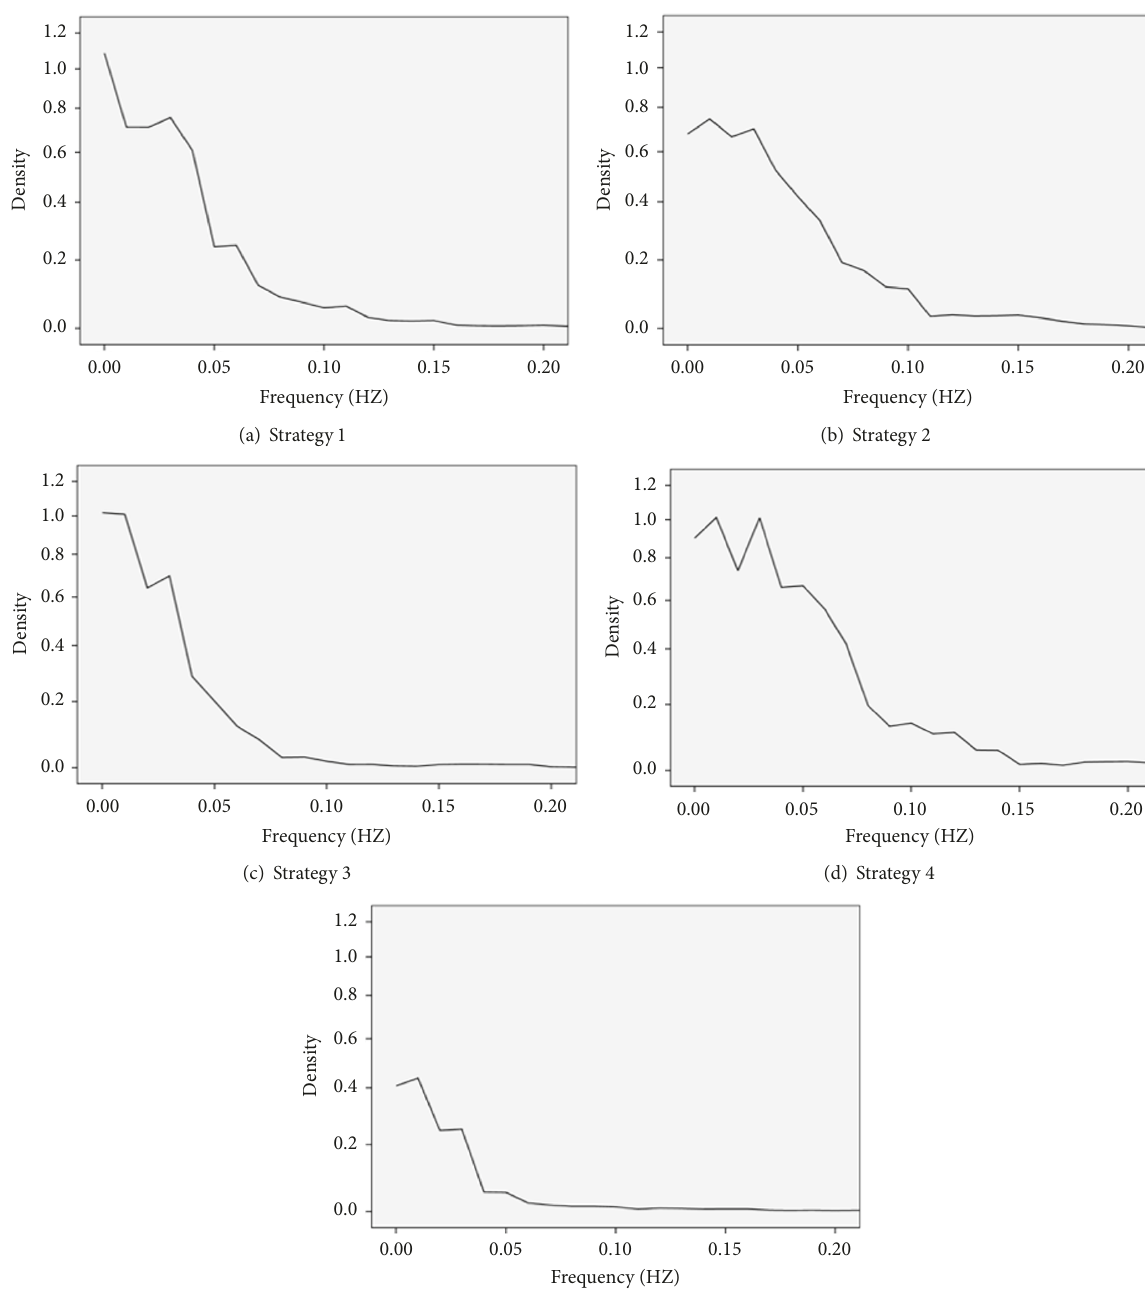
Figure 8: Frequency spectra of the driver’s